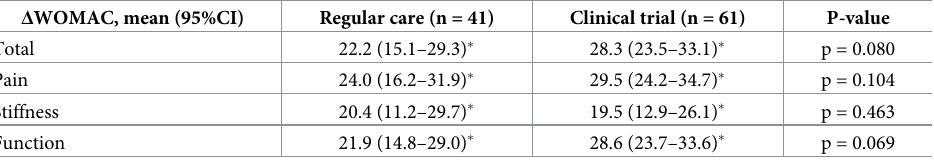
Table 4. Clinical outcome for patients treated with knee joint distraction in regular care and in clinical trials. Δ WOMAC, mean